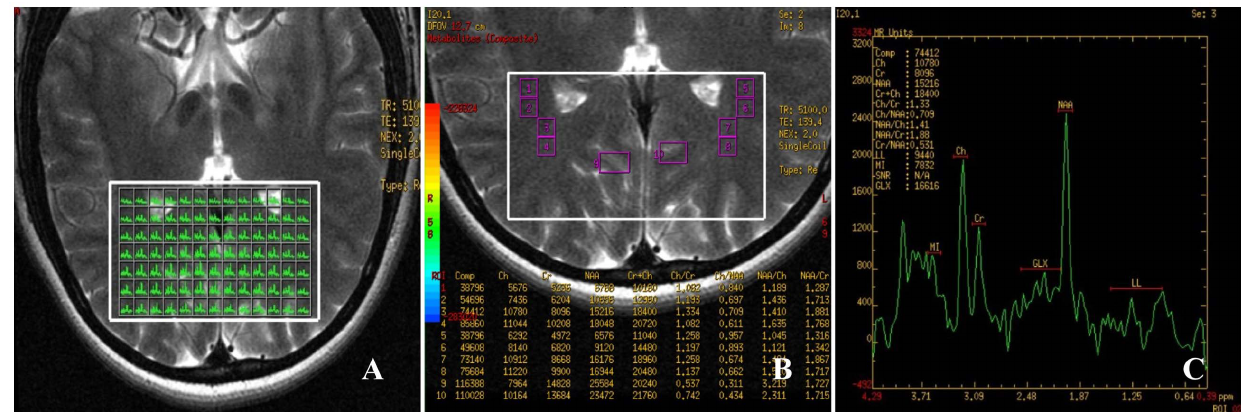
Figure 3. Example of region of interest and spectra. Figure 3A displayed all the fixed-voxels in the VOI (white box). The size of each voxel was 31.6 mm 2 , as recommended by the software. Figure 3B was the amplification of Figure 3A. Select several individual voxels as the ROIs in bilateral GCTs and the striate area. ROI 1 to ROI 8, all of which were individual voxels, distributed symmetrically in bilateral GCTs. ROI 9 and ROI 10 located in the striate area, each contained six voxels. Figure 3C was the spectra of ROI 2 in the right GCT, with NAA and Cho peaks.